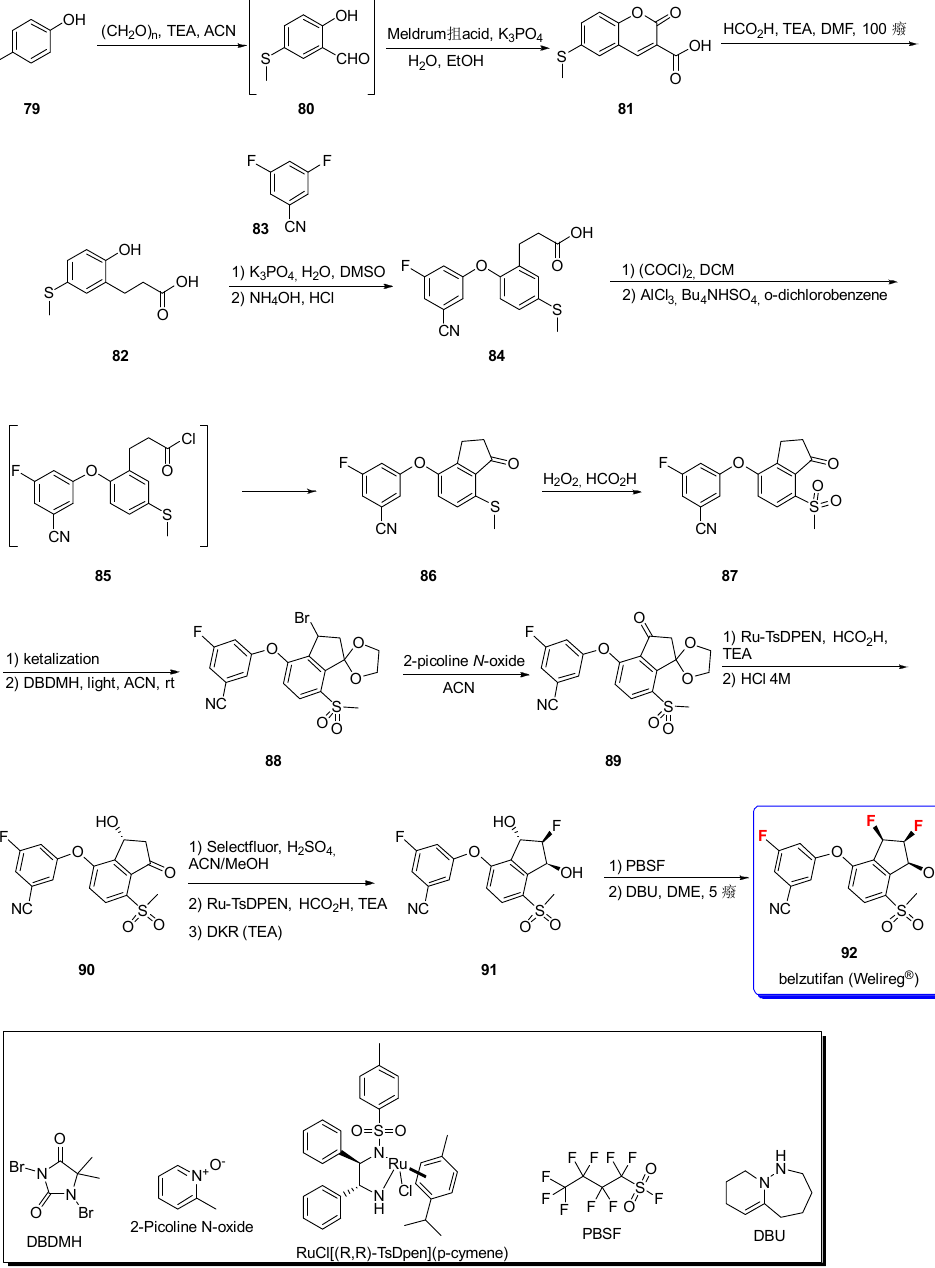
Scheme 12. Synthetic pathway for belzutifan ( 92 ) [52].